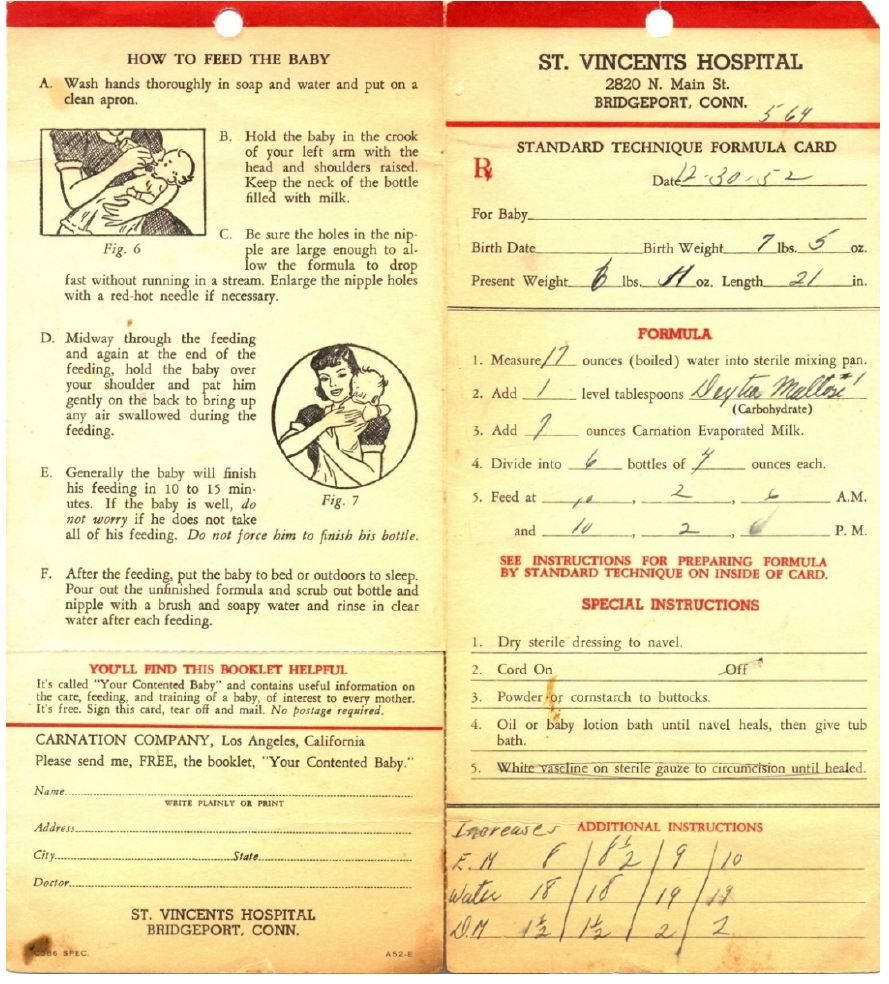
Figure 8. Recipe, or “Formula,” for Baby’s Food.